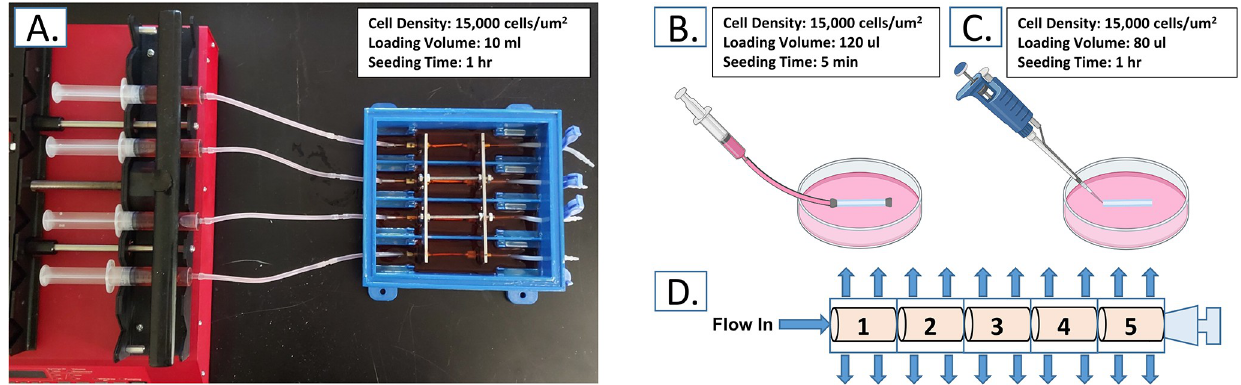
Fig 2. Seeding methodology. Seeding method diagrams for (A) the bioreactor mediated perfusion seeding method, (B) static injection counterpart seeding method and (C) drip seeding. (D) Operating principle of bioreactor mediated perfusion seeding method. Numbers indicate sample organization for